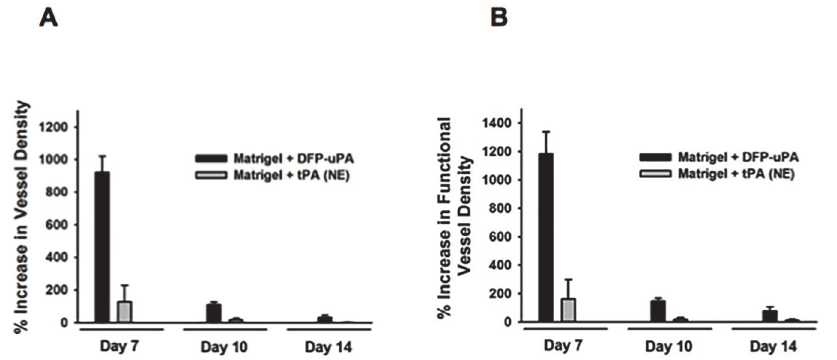
Figure 7. Effect of surface coating of implants with DFP-uPA or NE-tPA on vascularization of PPE biomaterial. Vascularization of PPE implants, which were coated with DFP-uPA or NE-tPA embedded in Matrigel, was analyzed by in vivo fluorescence microscopy in WT mice. Panels show results for the relative increase in absolute ( A ) and functional ( B ) vessel density within the implant as compared to Matrigel-coated control implants (mean ± SEM for n = 5 –